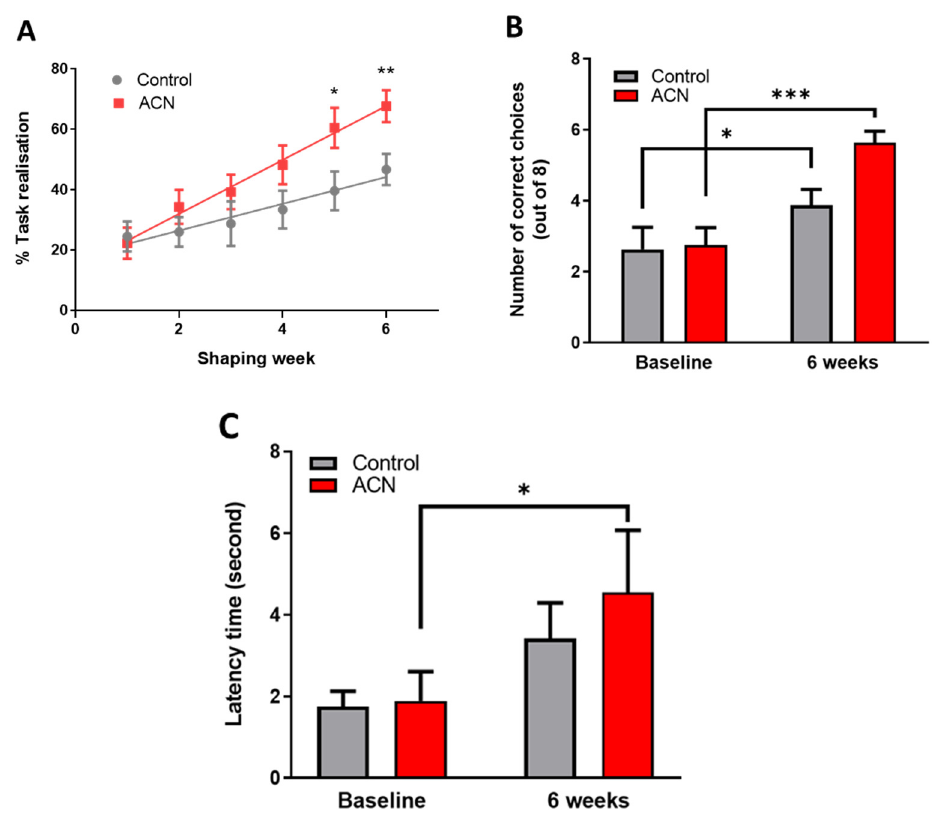
Figure 1. ( A ) Effect of anthocyanin (ACN) supplementation on learning the cross-maze rules during the shaping sessions. Results are presented as percentage ± SEM of task realisation ( n = 8). Two-way ANOVA indicated a significant time (F (5, 153) = 12.80, p < 0.0001) and treatment (F (1, 34) = 4.892, p = 0.0338) but no significant interaction (F (5, 153) = 1.584, p = 0.1677) impact on task realisation. Bonferroni post-hoc test indicated a greater effect of anthocyanins on completing the task versus control treatment following 6 weeks of shaping sessions. * p < 0.05, ** p < 0.01, *** p < 0.001. ( B ) Effect of anthocyanin (ACN) supplementation on spatial memory performance measured as choice accuracy (number of correct choices) in a T maze apparatus. Maximum score is eight correct choices. Results are presented as means ± SEM ( n = 8). Two-way ANOVA indicated a significant time effect (F (1, 14) = 39.09, p < 0.0001) and interaction (F (1, 14) = 6.067, p = 0.0273), but no significant effect of treatment F (1, 14) = 2.465, p = 0.1387) on overall cognitive performance. Bonferroni post-hoc test analysis indicated a greater effect of the anthocyanin-rich extract versus control on spatial working memory following 6 weeks of shaping sessions. ( C ) Effect of anthocyanin (ACN) supplementation on latency time to fall from the rotating rod. Results are presented as means ± SEM ( n = 8). The latency time to fall was significantly affected by time (F (1, 14) = 14.72, p = 0.0024) but not by treatment (F (1, 12) = 0.2566, p = 0.6217). No interaction between treatment and time was observed (F (1, 12) = 0.7910, p = 0.3913). Subsequent post-hoc analysis revealed that anthocyanin fed animals maintained a better dynamic equilibrium ( p = 0.0017) compared to those fed a control diet ( p = 0.1183) following 6 weeks of